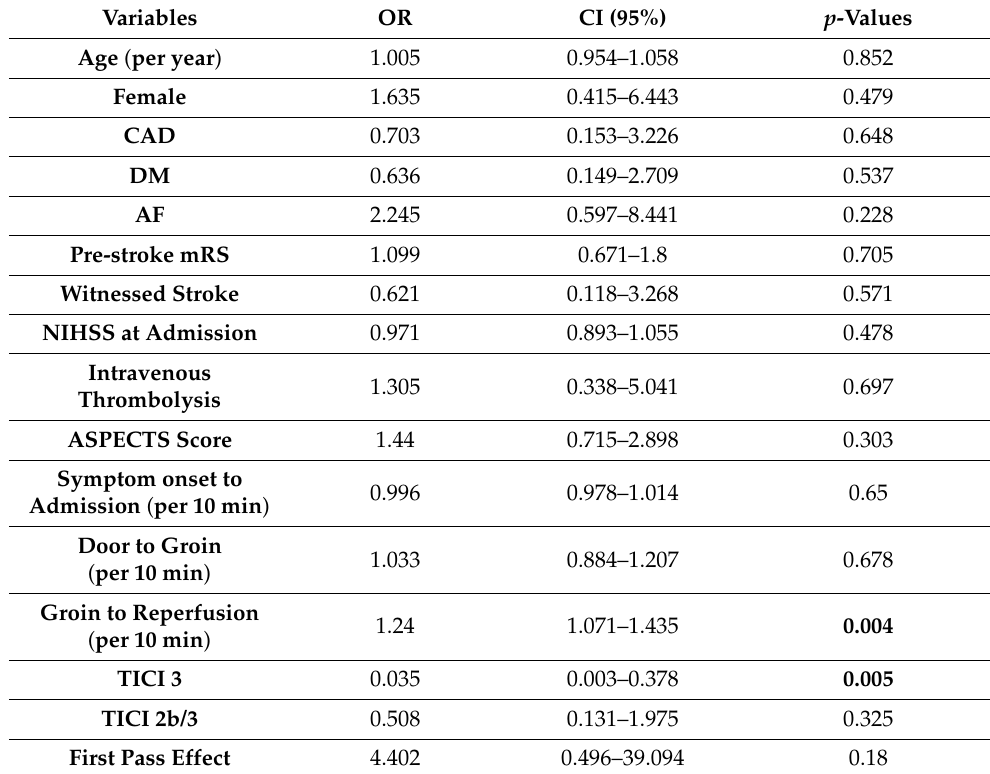
Table 2. Predictors of symptomatic intracranial hemorrhage in a smoothed ridge regression